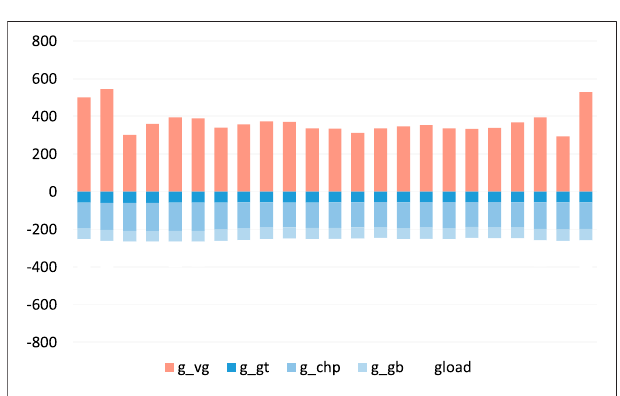
FIGURE 9 | Operation of the gas